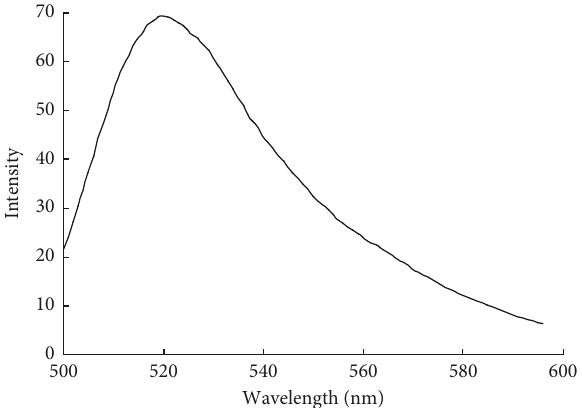
Figure 2: Fluorescence spectrum of